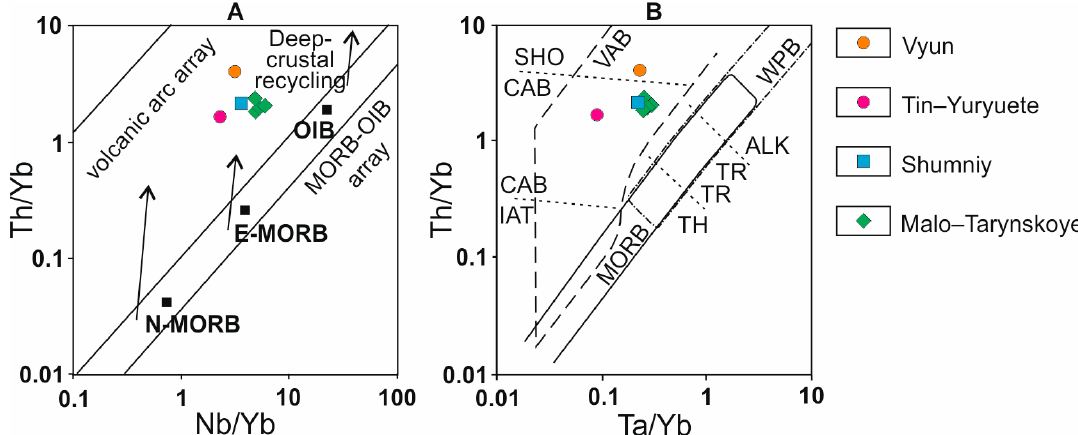
Figure 8. Tectonic setting discrimination diagrams for the mafic igneous rocks: ( A ) Th/Yb versus Nb/Yb from [66]; ( B ) Th/Yb versus Ta/Yb from [67]. All data points on this diagram are from this study. Abbreviations are types of mafic volcanic rocks: MORBs—middle ocean ridge basalts; N-